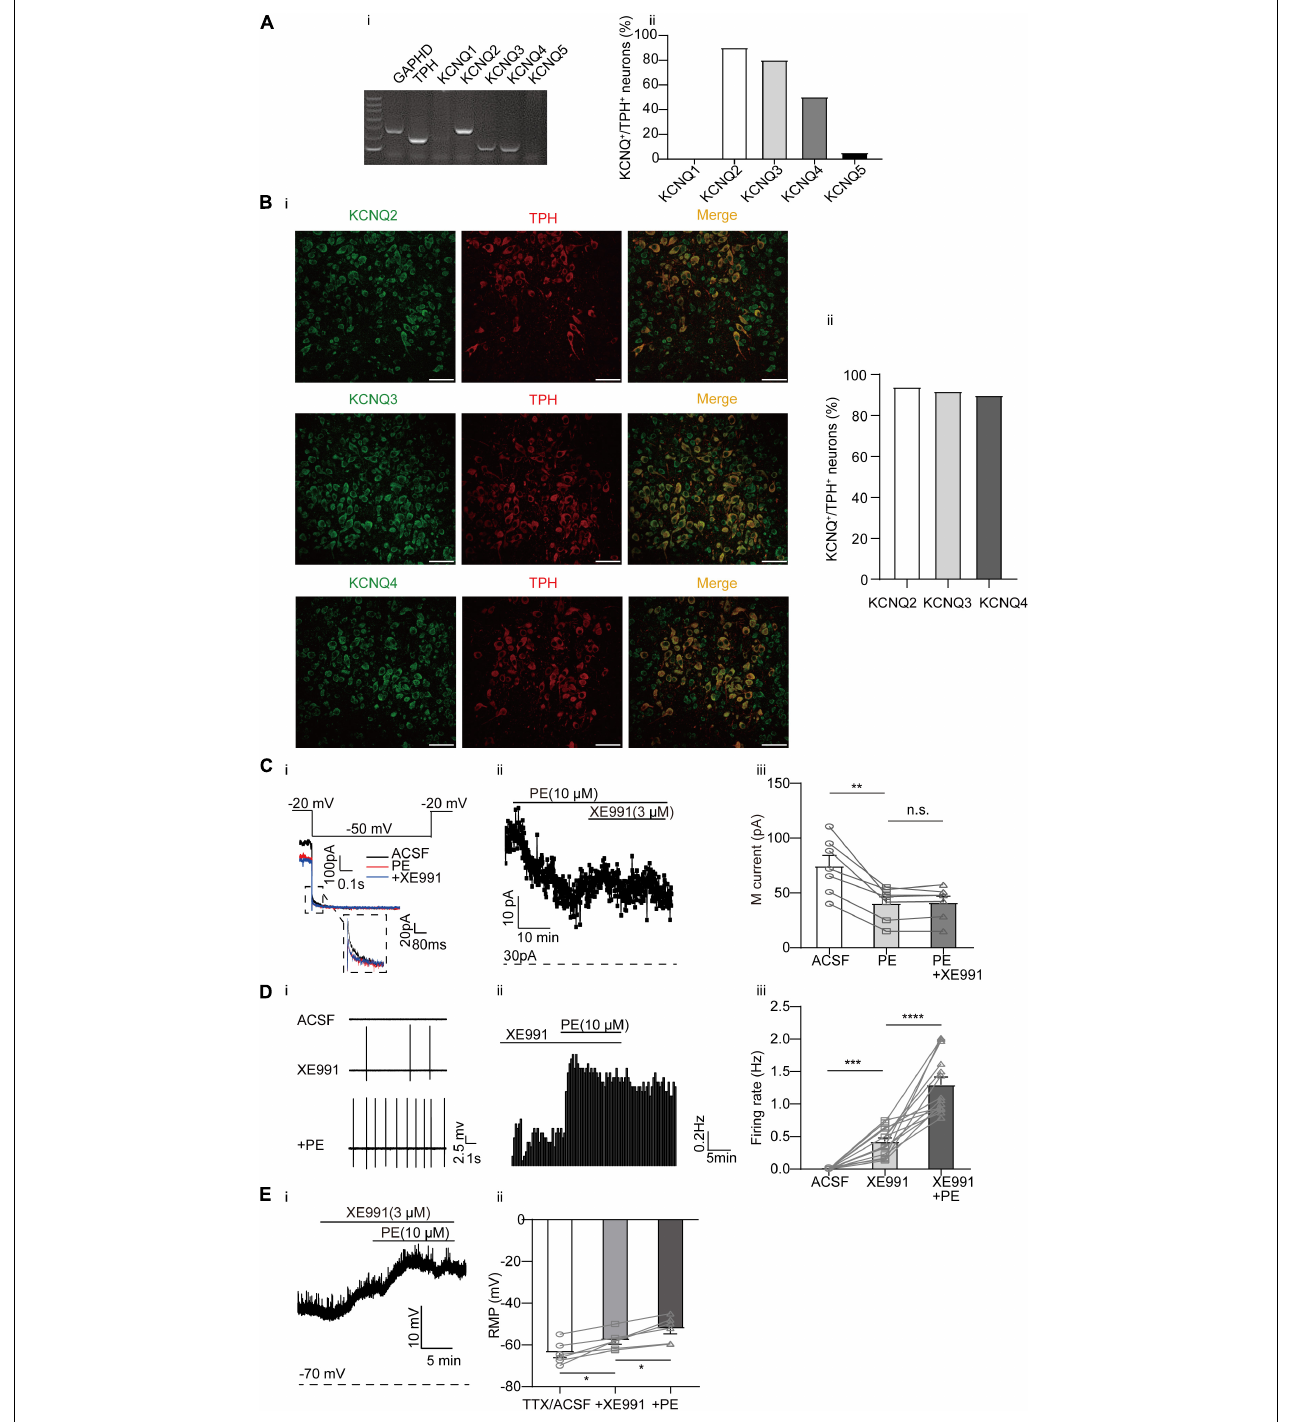
FIGURE 3 | Expression of M-type K + channels and their contribution to the PE-induced spontaneous firing of the DRN 5-HT neurons. (A) Expression of M-type K + channel-related subfamily members assessed using single-cell PCR analysis in the DRN neurons. (i) Representative image of single-cell PCR products showing the presence of different KCNQ subunits. (ii) Proportion of KCNQ1–5 positive neurons in the TPH-positive neurons ( n = 20). (B) (i) Confocal images of KCNQ2, KCNQ3, and KCNQ4 expression in slice of the DRN, assessed using immunofluorescence methods. Scale bar = 50 µ m. (ii) Proportion of KCNQ2, KCNQ3, and KCNQ4 positive neurons in the TPH-positive neurons ( n = 200). (C) PE potently inhibited M-type currents recorded using whole-cell patch clamp in the DRN 5-HT neurons. (i) Recording protocol used and the typical current traces recorded; the latter were from –20 mV. The current amplitude at the beginning of the –50 mV step